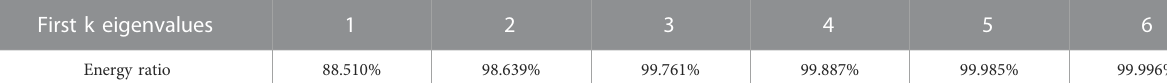
TABLE 2 Energy ratio of fi rst k eigenvalues of case 2.